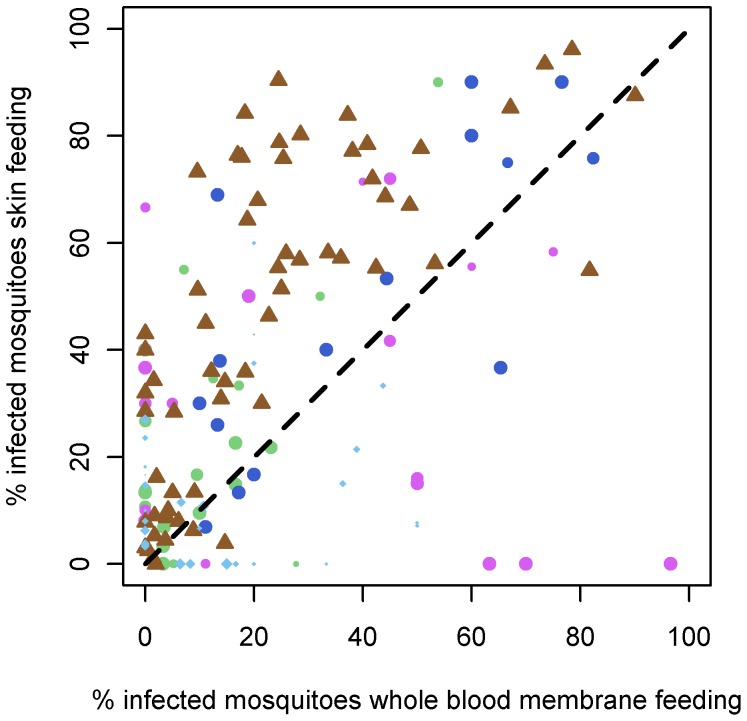
The association between mosquito infection rates in skin feeding experiments and whole blood membrane feeding assays.The proportion of infected mosquitoes in whole blood membrane feeding assays (X-axis) is strongly associated with the proportion of infected mosquitoes in skin feeding assays (Spearman's rho 0.36, p<0.0001). Point size, shape and colour are as described in Figure 3. The shape of the point denotes the country the experiment was carried out in, be it Cameroon (circle), Mali (triangle) or Senegal (diamond).